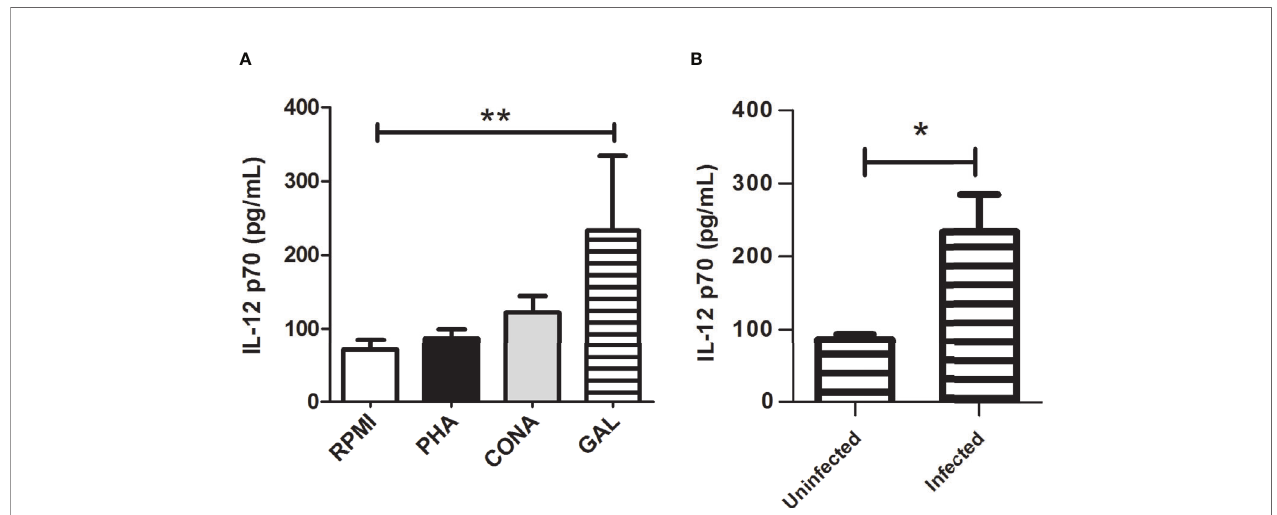
FIGURE 5 | Culture supernatant production of IL-12 p70 by Leishmania infected macrophages treated with GAL. (A) The amount of IL-12p70 was assessed in infected cultured RAW 264.7 macrophages maintained alone (RPMI) or treated with phytohemagglutinin (PHA), concanavalin A (CONA) and galangin (GAL). Each variable was performed in quadruplicate. Comparison among groups were assessed by Kruskal-Wallis test and Dunn`s post-test (** p < 0.01). (B) Production of IL- 12p70 after the addition of GAL to uninfected vs . infected cultured macrophages. Analysis performed by Mann Whitney test (* p <